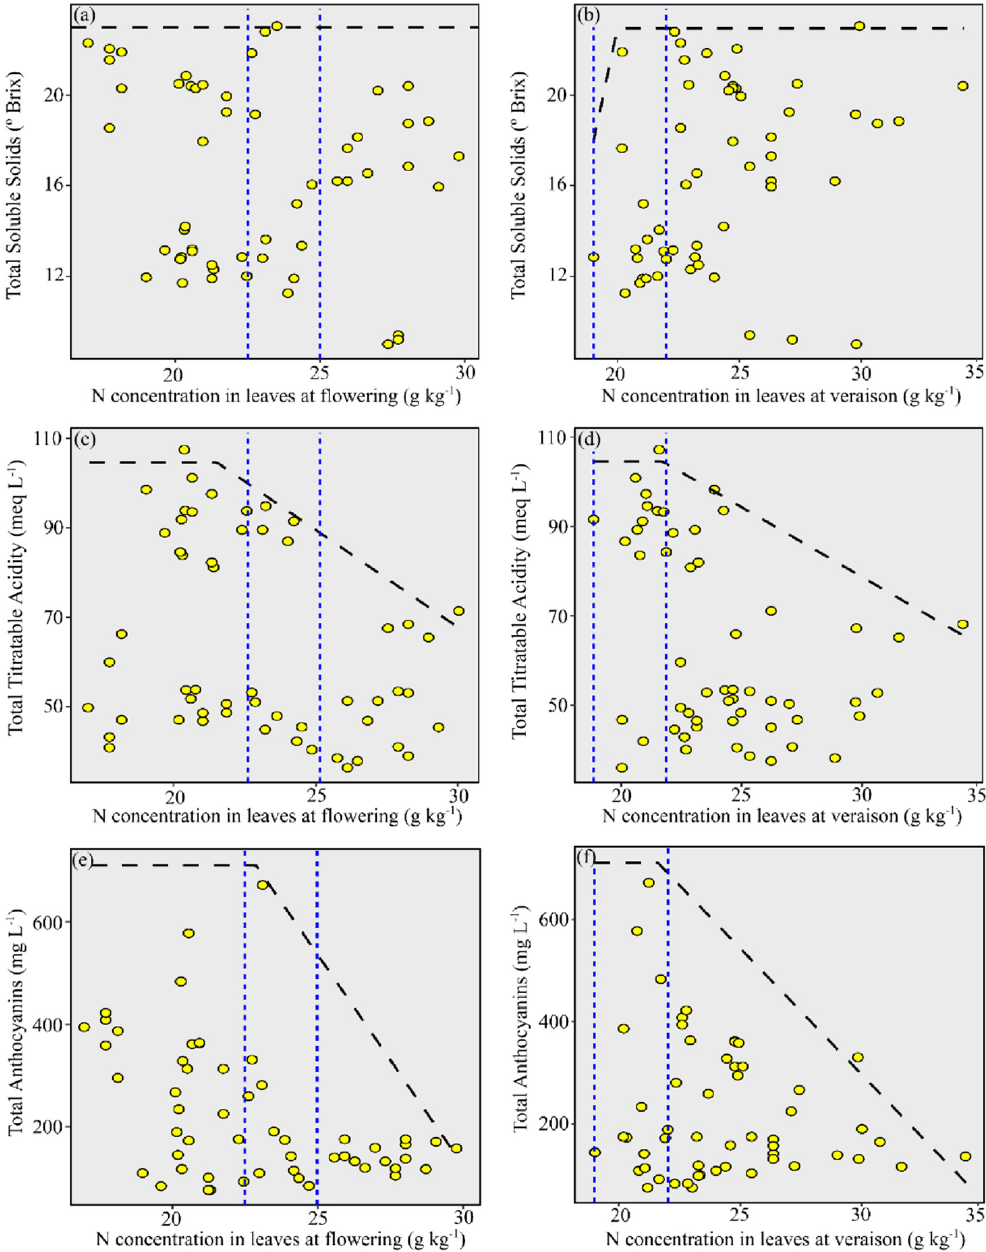
Figure 6. Relationship between N concentration in leaves at flowering and veraison and the total soluble solids ( a , b ), and the total titratable acidity ( c , d ), and total anthocyanins ( e , f ) of ‘Pinot Noir’ grape must during 2016/17, 2017/18, and 2018/19. Blue dashed lines represent the proposed N sufficiency ranges based on maximum grape yield.